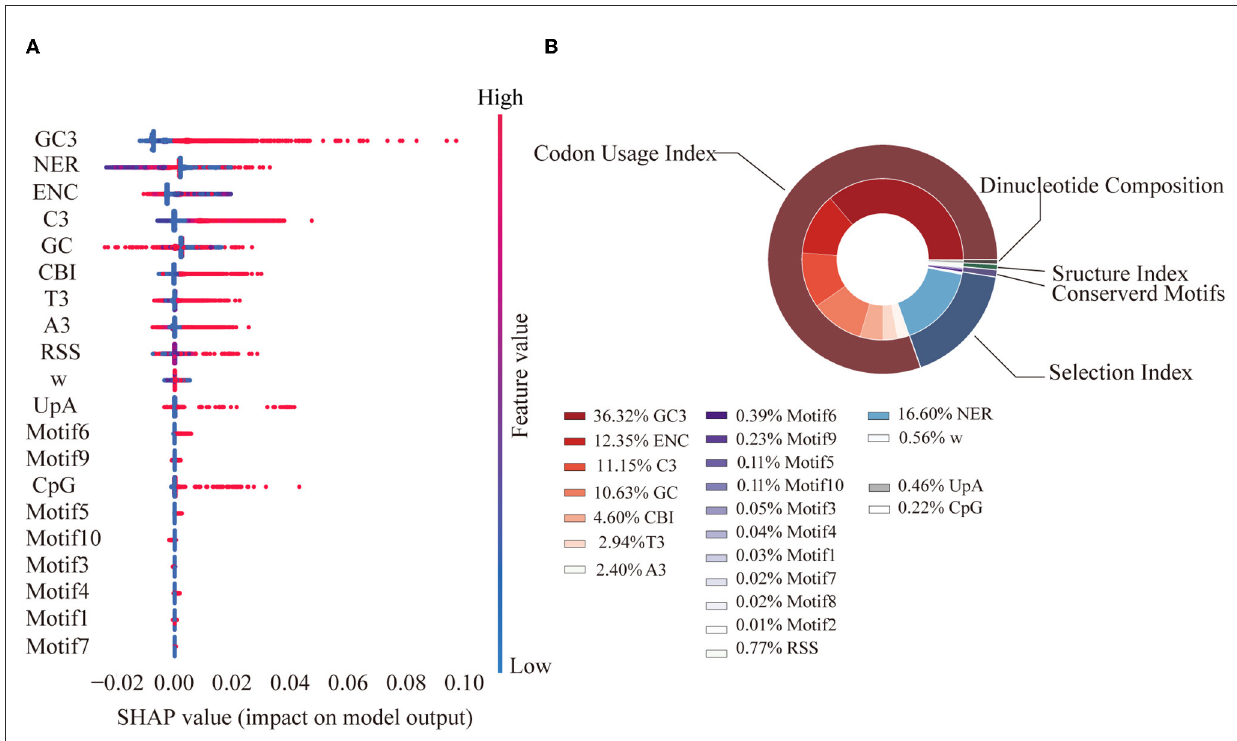
FIGURE3 Feature SHAP value and contribution. (A) SHAP value for the top 20 features. Each point represents a sample. A SHAP value greater than 0 contributes to a higher SER, while a value less than 0 contributes to a lower SER. Feature value represents the value of each sample. (B) Feature importance pie chart. The outer ring represents the grouping, while the inner ring represents each specific feature. Percentage represents the proportion of the total